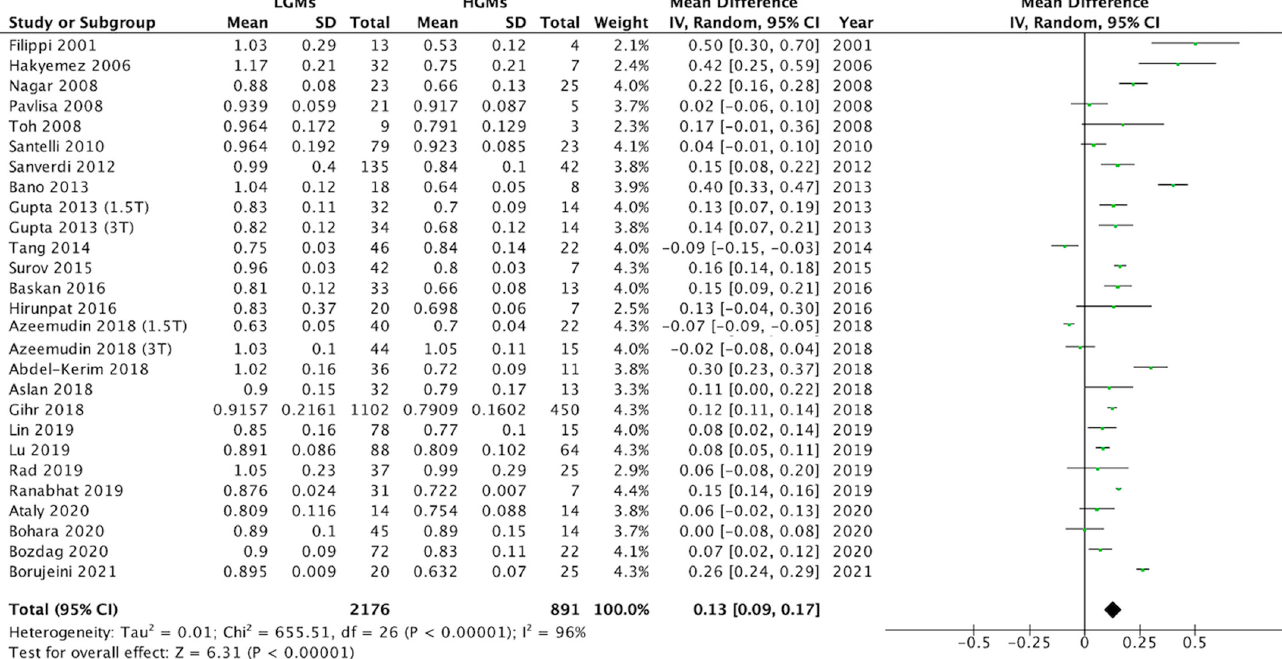
0.08, 95% CI = 0.04 to 0.13, p = 0.0004; I 2 = 69%; 6 studies; n = 496) (Figure 3b).